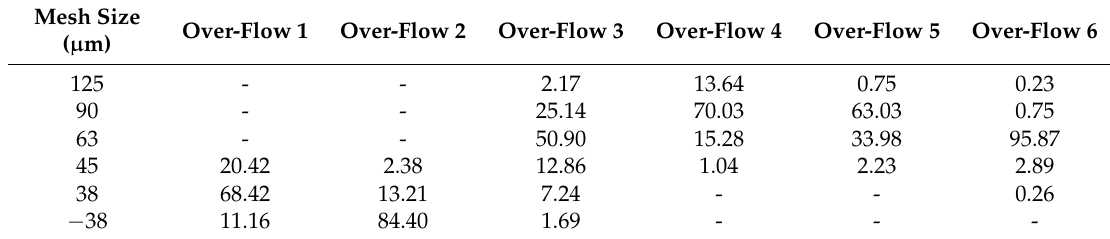
Table 3. Sieving results of hydrocyclone overflow in percent.